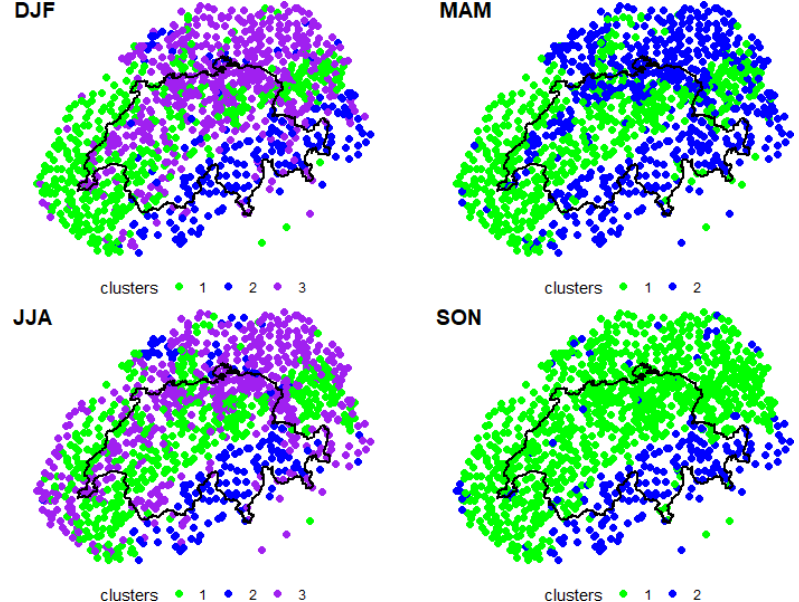
Figure 2. Maps of Switzerland showing the optimal number of clusters identified with the PAM algorithm for each season. For each season, the regions identified are color-coded. From top left, going clockwise, DJF (two clusters), MAM (two clusters), JJA (three clusters) and SON (three clusters).